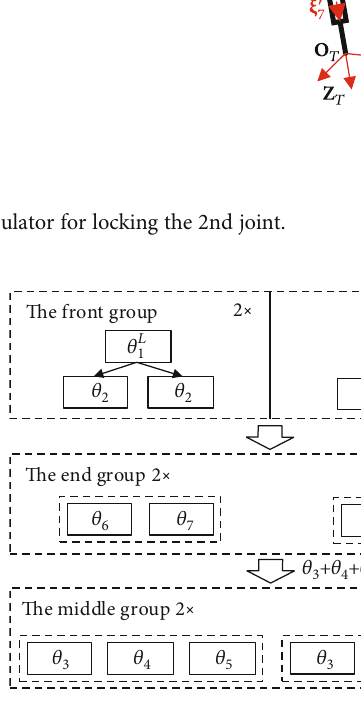
Figure 9: Flowchart of the solution